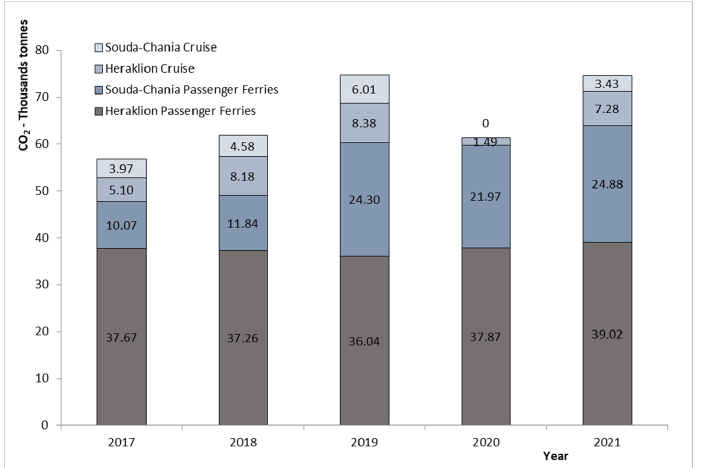
Figure 3. Annual CO 2 emissions during years 2017–2021 for Souda and Heraklion ports.